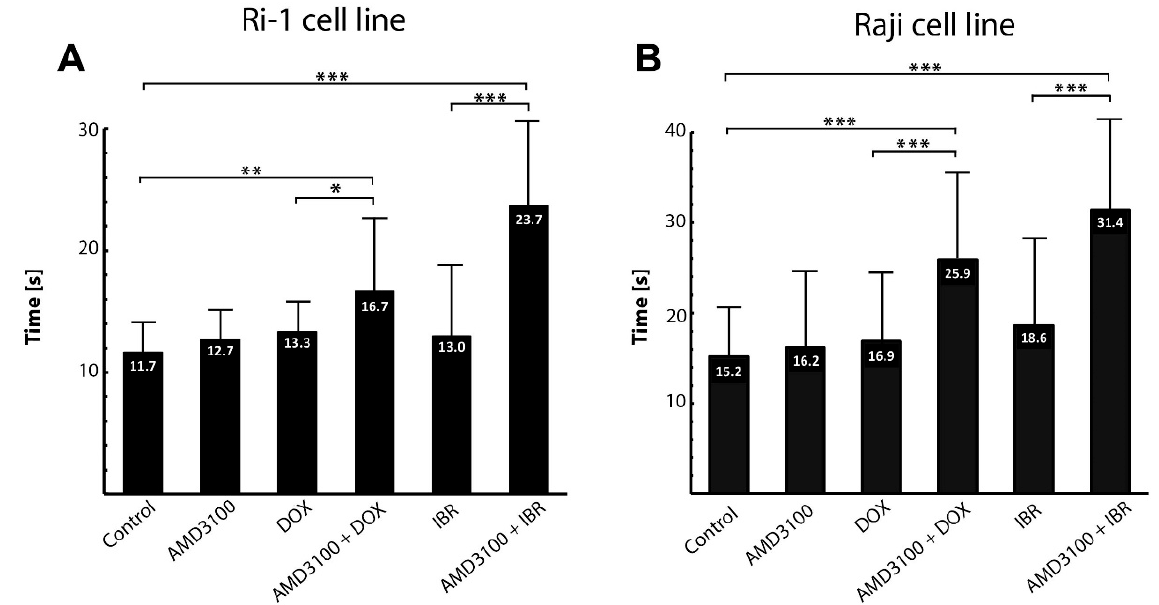
Figure 4. The effect of the anticancer treatment on the adhesion of Ri-1 ( A ) and RAJI ( B ) cell lines to the stromal spheroid evaluated in OT. Error bars represent the standard error of the mean calculated from three independent measurements. DOX, doxorubicin; IBR, ibrutinib. * p -value < 0.05, ** p -value < 0.01, *** p -value < 0.001.